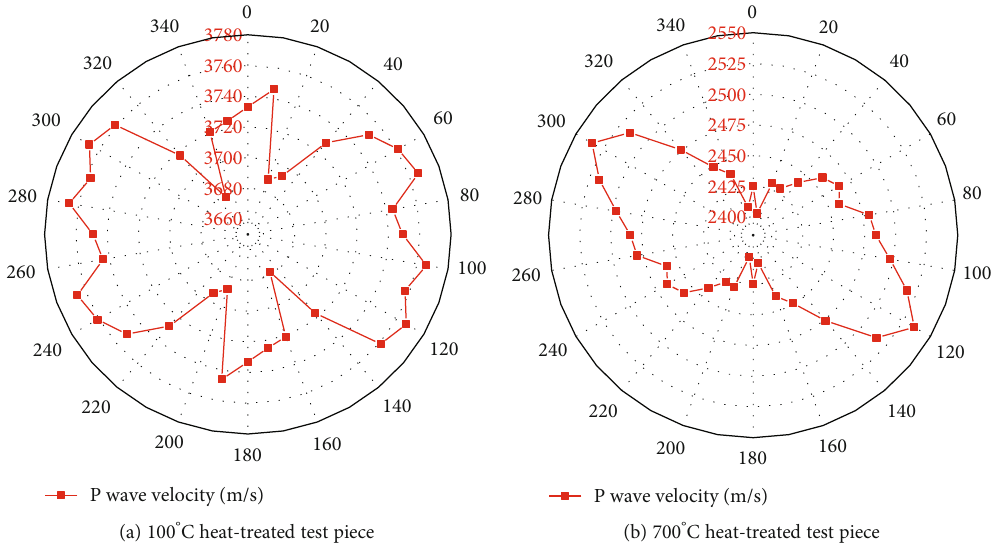
Figure 12: Radar map of the circumferential wave velocity anisotropy.